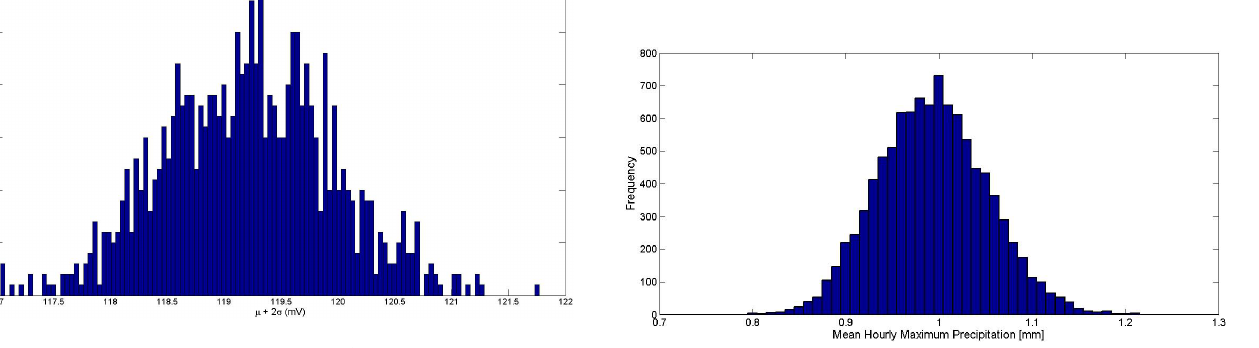
Fig. 7. Statistical sampling distribution of the sample mean max- imum hourly precipitation observation added to twice the sample standard